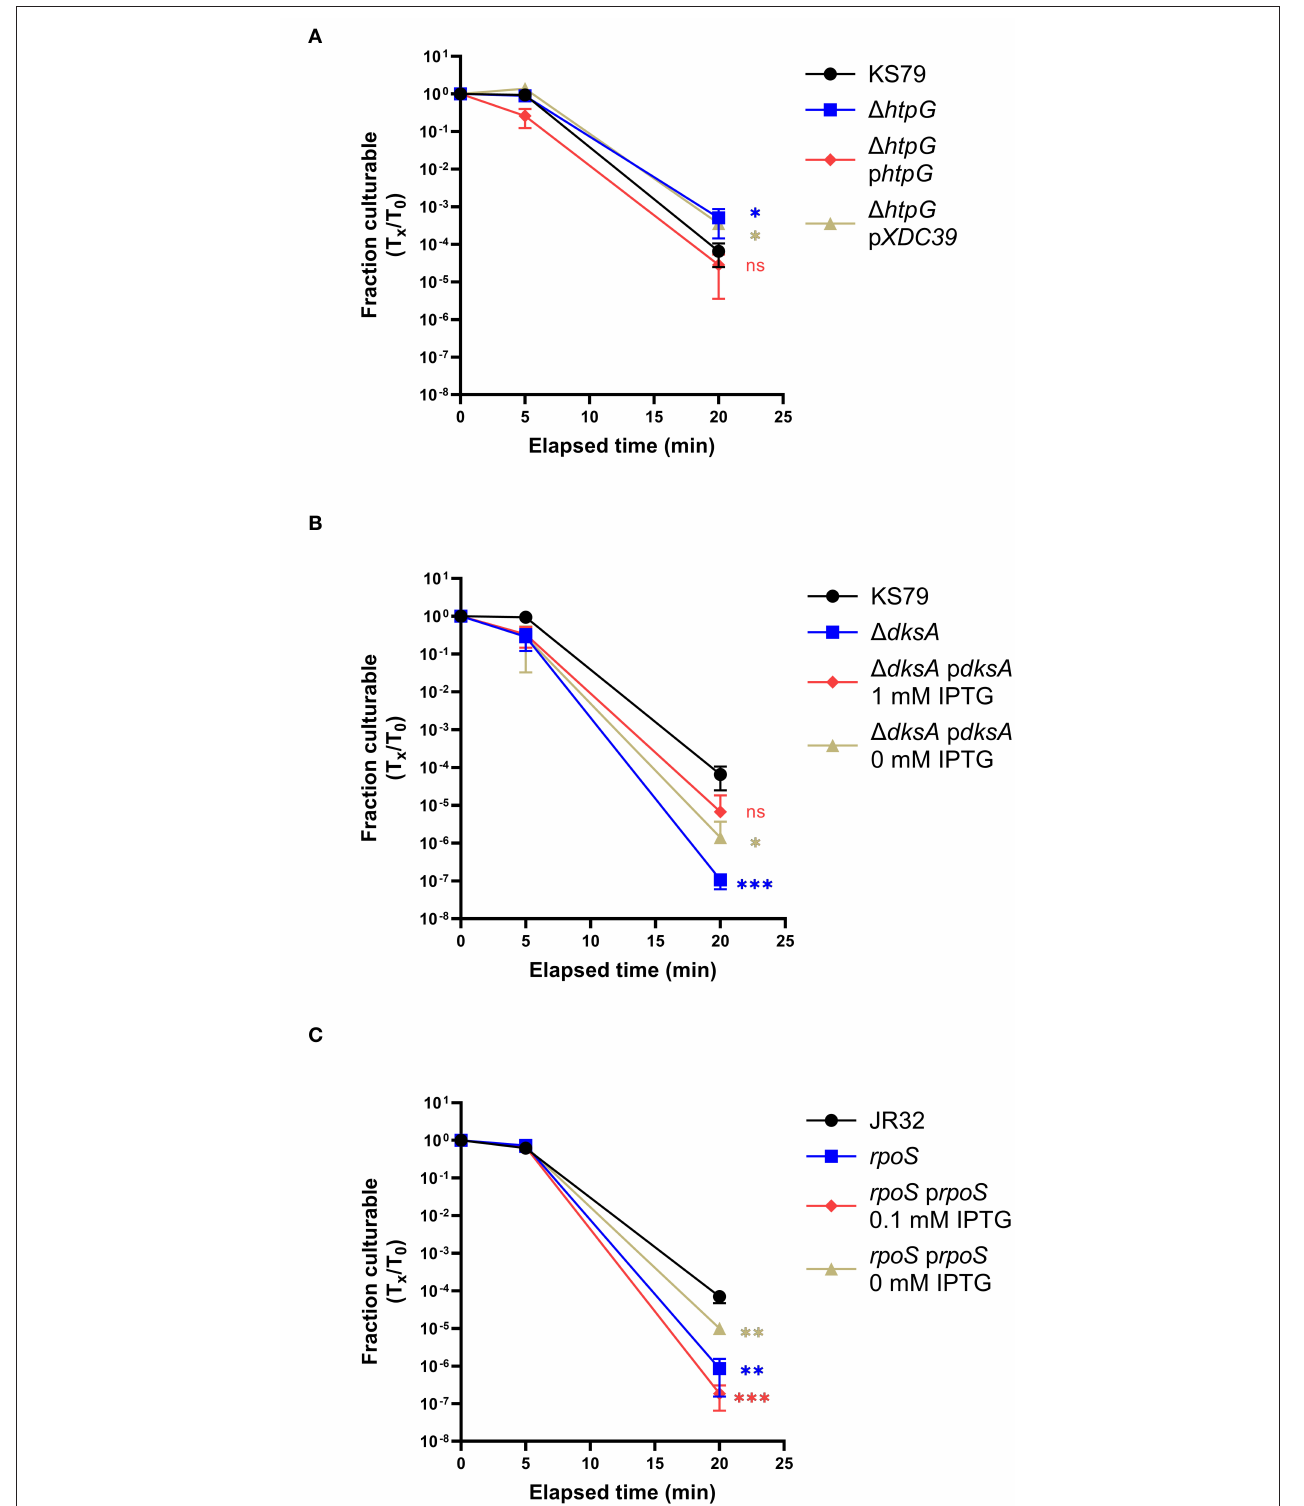
FIGURE 4 | Effects of htpG , dksA , and rpoS on heat shock tolerance. Strains washed in and acclimated to Fraquil were heat shocked at 55 ◦ C for 5 or 20min. (A) 1 htpG was compared with its ancestor and complemented with a plasmid-borne copy of htpG [ phtpG or with an empty vector control